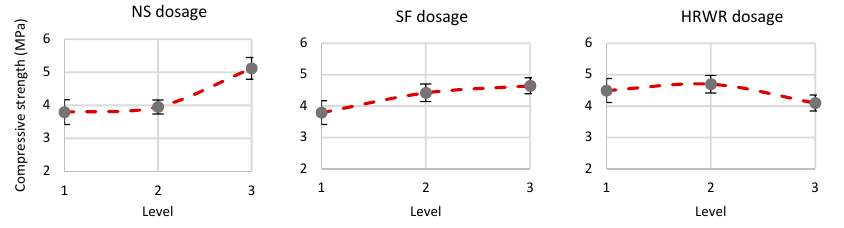
Figure 8. Influence of factors on compressive strength values.